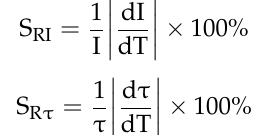
Figure 6. ( a ) Temperature dependence of the integrated intensity of CSO:Mn 2+ . ( b ) Energy-level diagram and the fluorescence process of CSO:Mn 2+ .